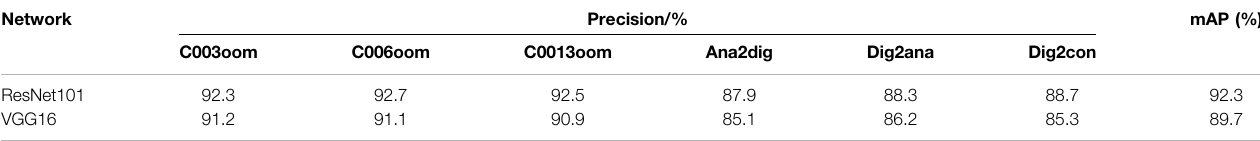
TABLE 3 | Comparison of logical element ’ s detection results of different feature extraction networks. Network